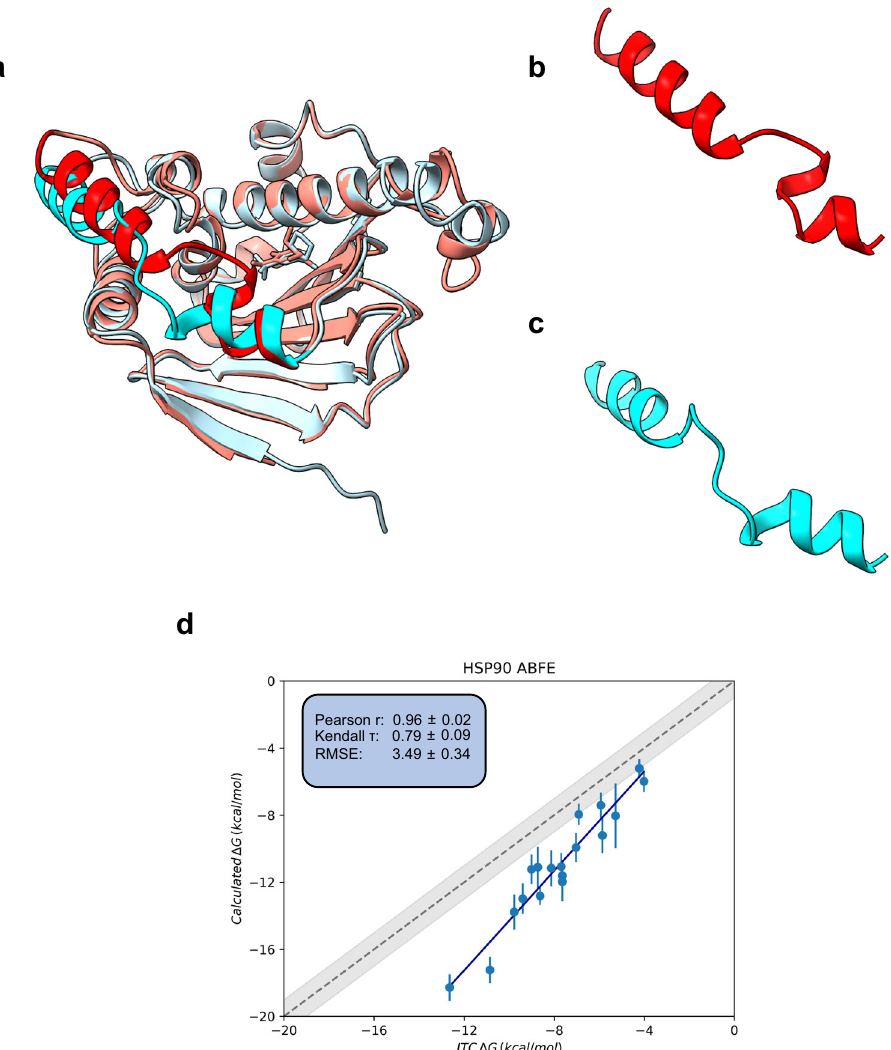
Fig. 4 Impact of conformation on ABFE calculations for HSP90. a Comparison of the structures of PDB IDs 2XHT (blue) and 2XDL (red) demonstrating the difference in helicity between the two models and b , c a zoomed view of the affected helix. Residues 100 – 124 have been highlighted in a darker colour to aid in visualisation. PDB ID 2XAB, which is similar in structure to 2XDL and 2XHX which is similar in structure to 2XHT are not shown. d Absolute binding free energies of the HSP90 ligands all starting from the 2XDL-like helix loop conformation. Free energy estimates are the means of the estimates across replicas, with error bars as their standard deviation. Correlation metrics calculated from the mean estimate values, with error bars derived from bootstrap resampling. All free energy results, including RMSE values, have units of